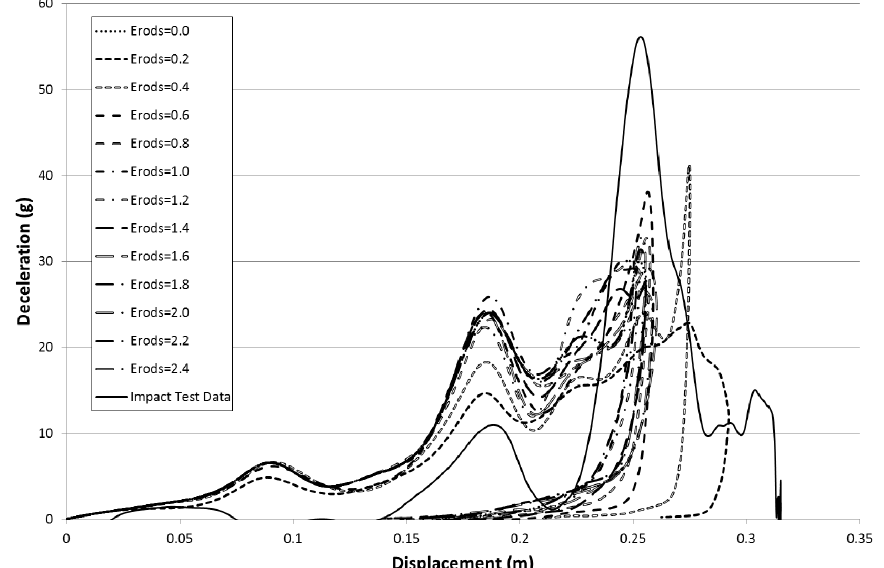
Figure 13. Effect of Erods parameter with All Slim = 1.0, TSize = 1 × 10 − 11 , Soft = 1.0 and FS = − 1.0.